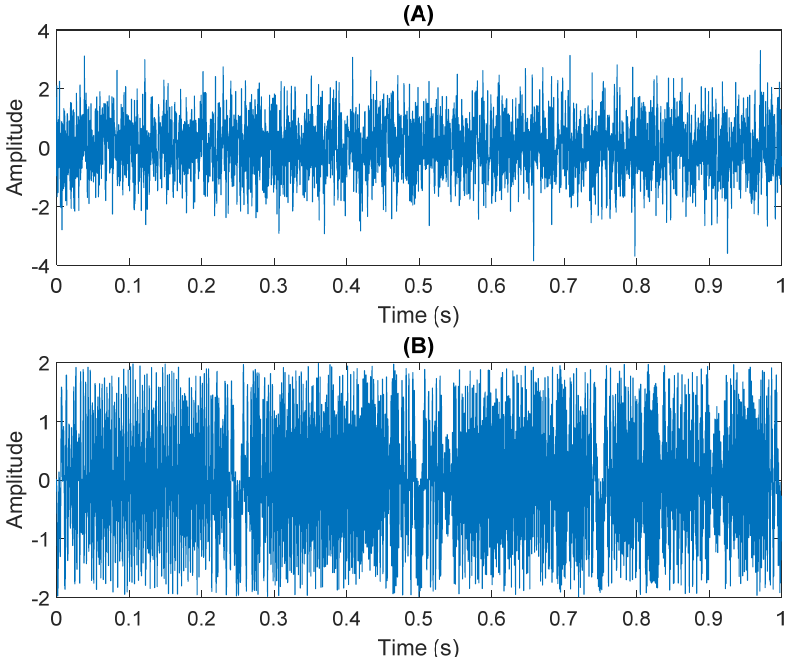
Figure 15. Analysis of data separated by ICA: ( A ) white Gaussian noise; ( B ) mixed sources.